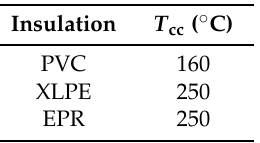
Table 3. Short-circuit temperature for each type of insulation.